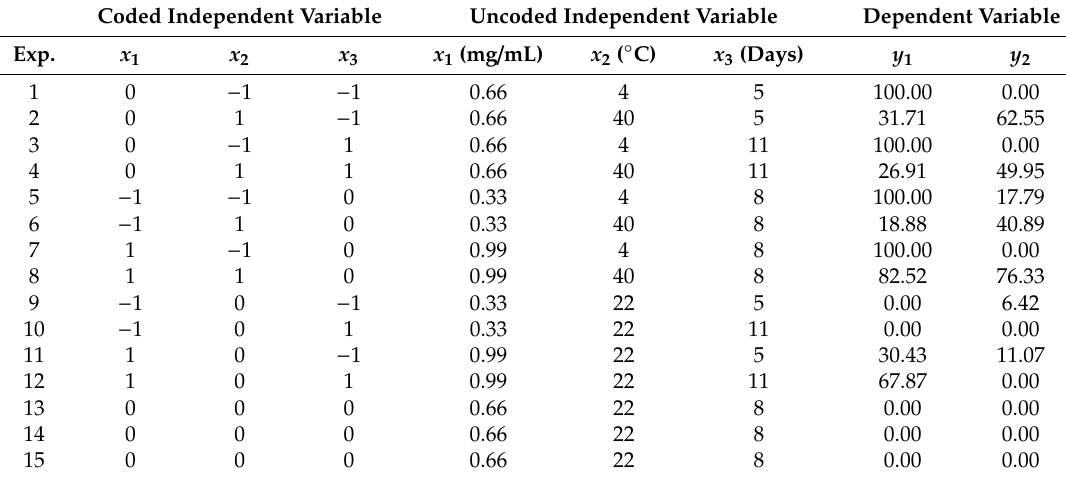
Table 2. Operational conditions used in this study, expressed as coded dimensionless and uncoded independent variables: concentration of the biosurfactant ( x 1 ), temperature ( x 2 ), and incubation time ( x 3 ); and the results obtained for the dependent variables: y 1 (% of growth inhibition of A. brasiliensis ) and y 2 (% of growth inhibition of C. albicans ). ( − 1, minimum value of the variable within the range; 0, central value of the variable within the range; 1, maximum value of the variable within the range). Coded Independent Variable Uncoded Independent Variable Dependent Variable